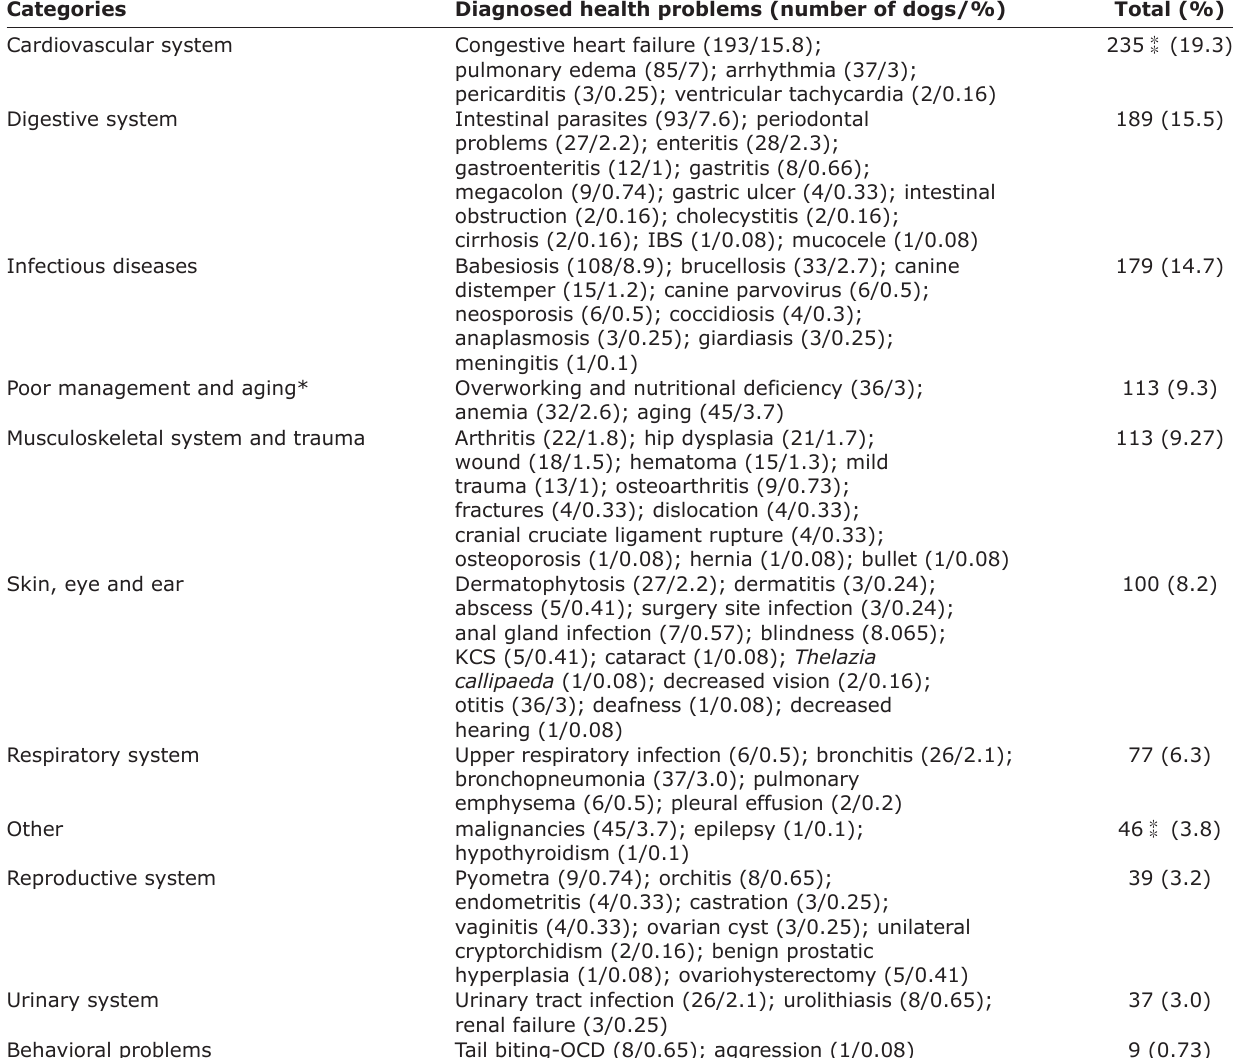
Table-2: Detailed diagnosed health problems of referred police dogs to Baghdad veterinary hospital in 2015-2017.